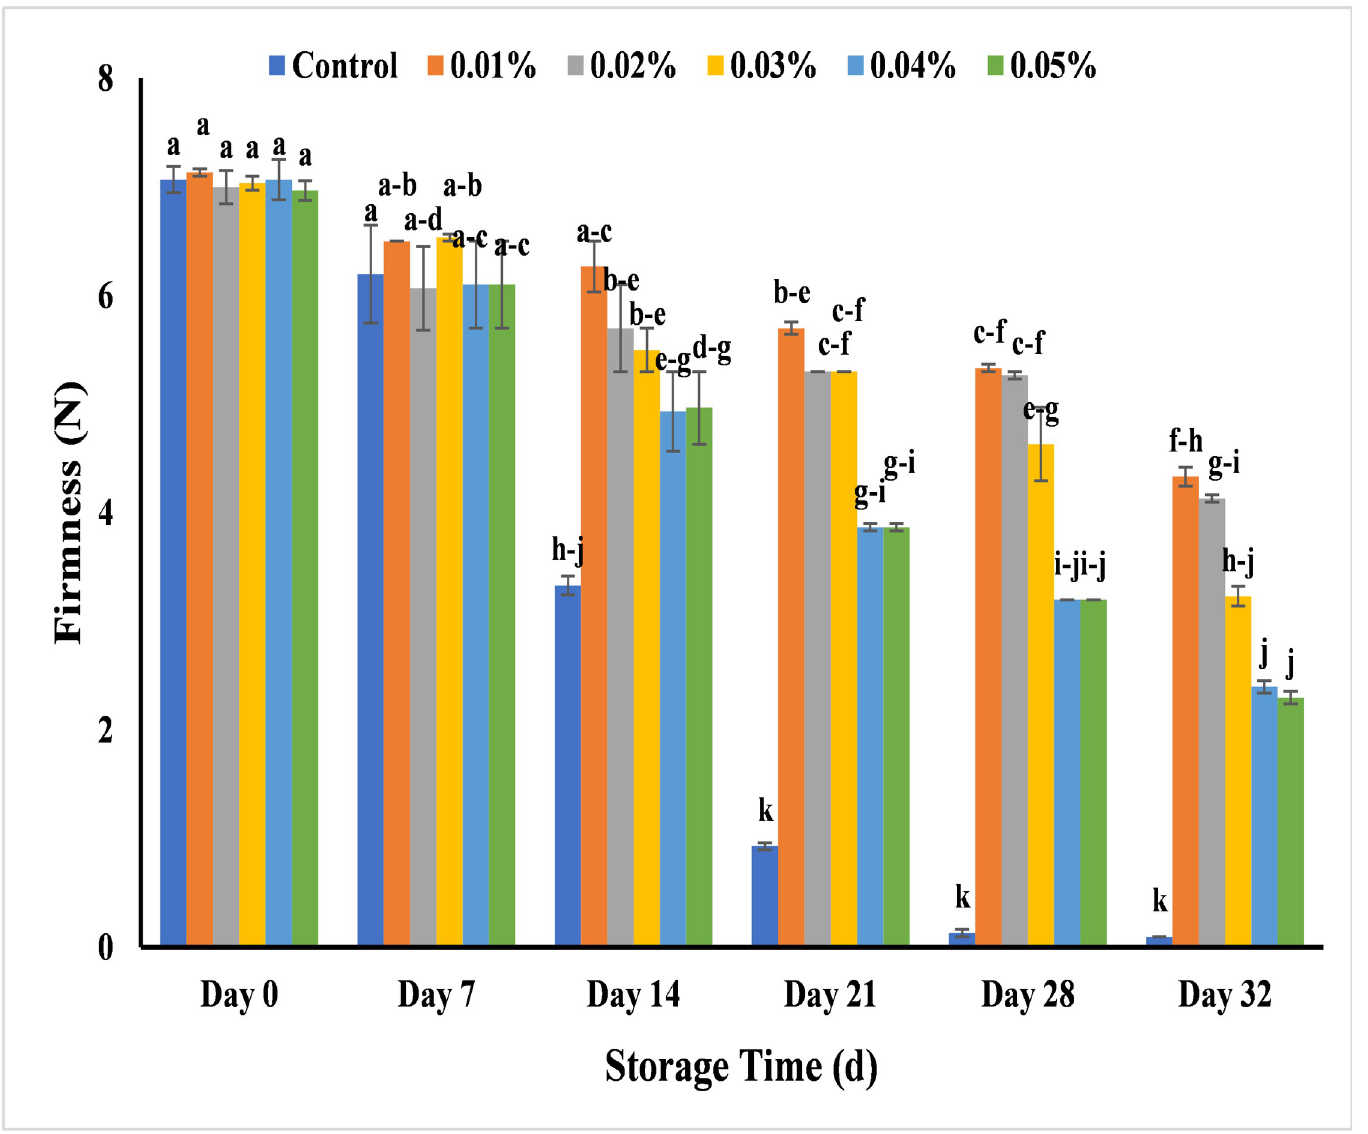
Fig 12. Effect of AgNPs concentrations (T0 = control, T1 = 0.01%, T2 = 0.02%, T3 = 0.03%, T4 = 0.04%, T5 = 0.05%) on firmness of Cavendish banana (BASRAI) during 32 days of storage.